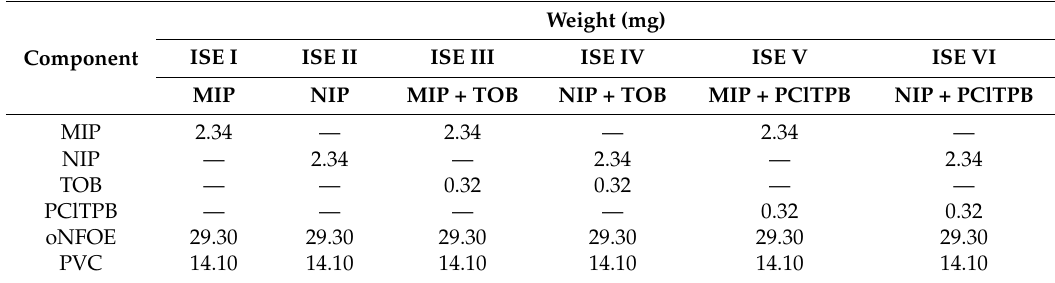
Table 1. Membrane composition of CA15-3